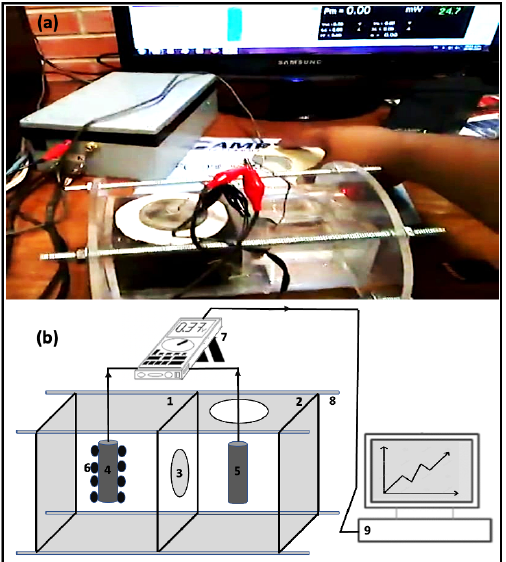
Figure 2. ( a ) Original experimental setup and ( b ) schematic diagram of the MFC system. (1) Anaerobic anode cell, (2) cathode cell, (3) Nafion membrane, (4) anodic graphite electrode, (5) cathodic graphite electrode, (6) biofilm (anaerobic sludge from a natural wetland), (7) multimeter, (8) bolt and nut set (cells connection), (9) computer for data analysis.